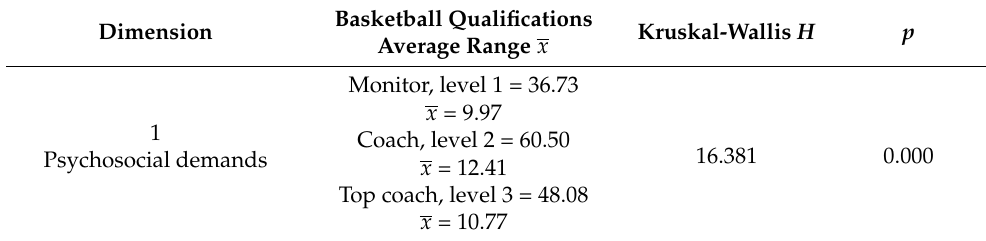
Figure A6. Comparison between pairs of the Psychological Distress in Non-Formal Contexts scale as a function of the years of experience variable. Table A4. Analysis of the components of the Psychosocial Risk Assessment Questionnaire in Non- Formal Contexts and basketball